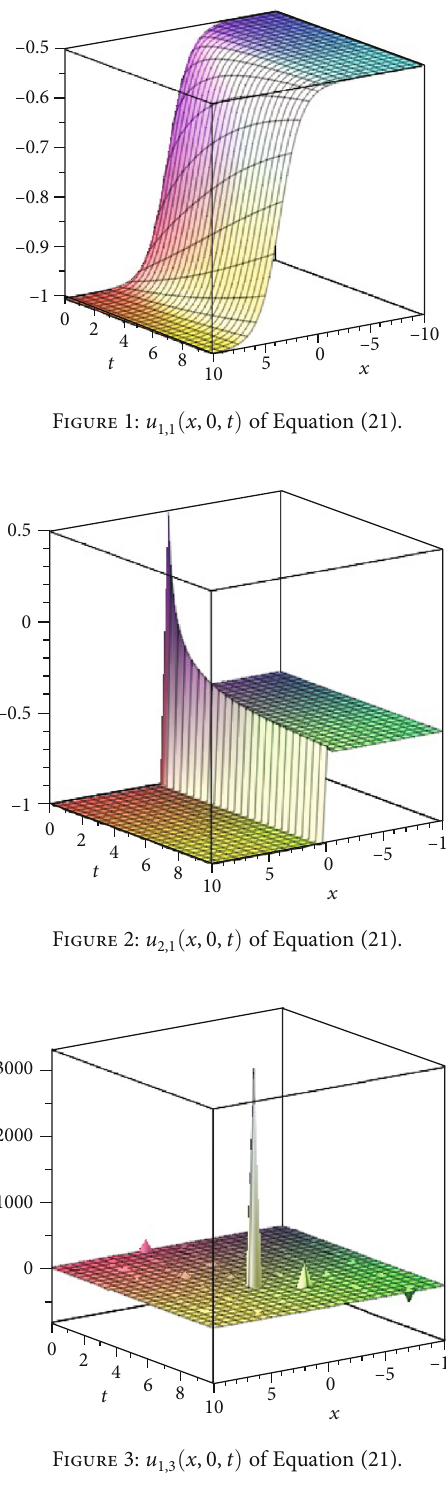
ð x , 0, t Þ of Equation Figure 6: u 5,5